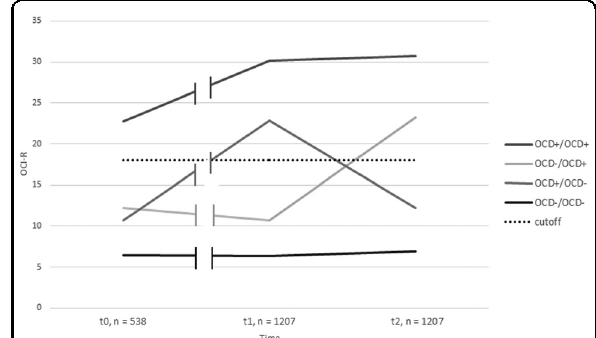
Fig. 1 Four trajectories of obsessive-compulsive symptoms (OCS) over the COVID-19 pandemic and OCI-R total score at t0 (March 2014), t1 (March 2020), and t3 (June 2020). The dotted line represents the cut-off point of the German OCI-R, above which symptom severity can be considered clinically